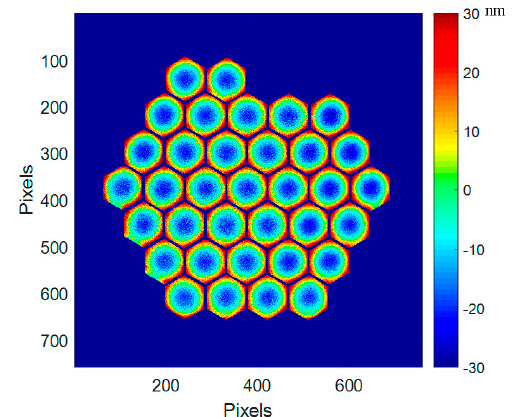
Figure 18. Segment deformation induced by the temperature change between ambient and cryo (160 K); map of all segments of PTT111.